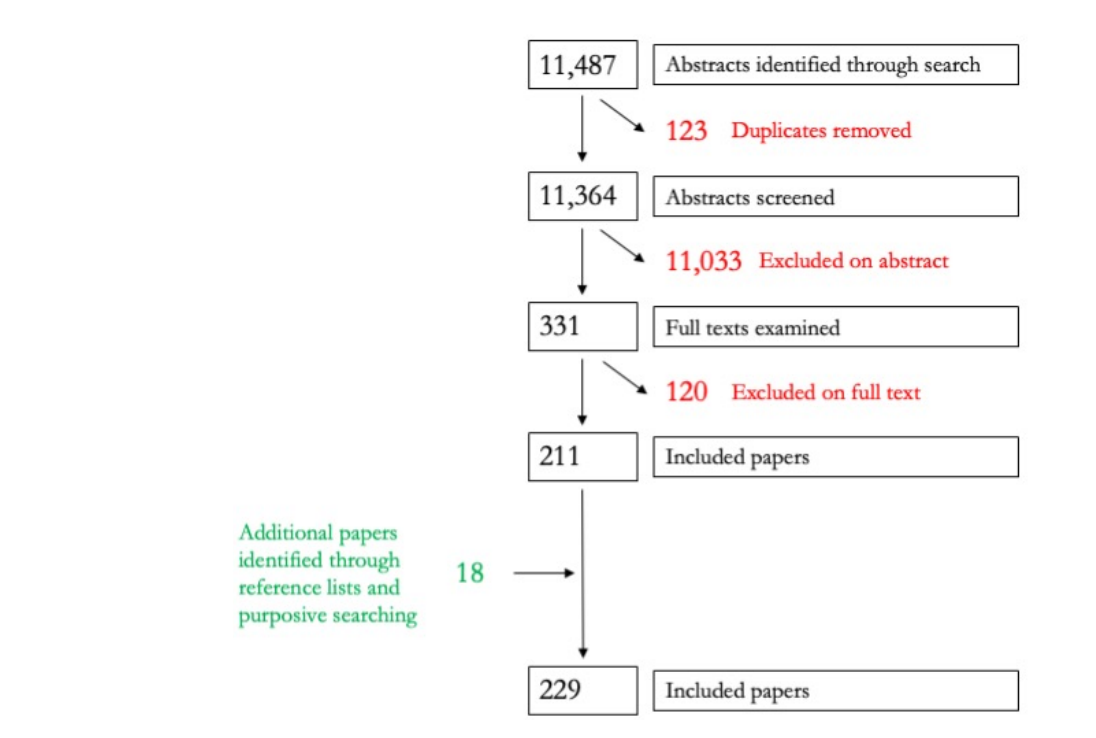
Figure 1. PRISMA flow chart for the peer-reviewed literature.